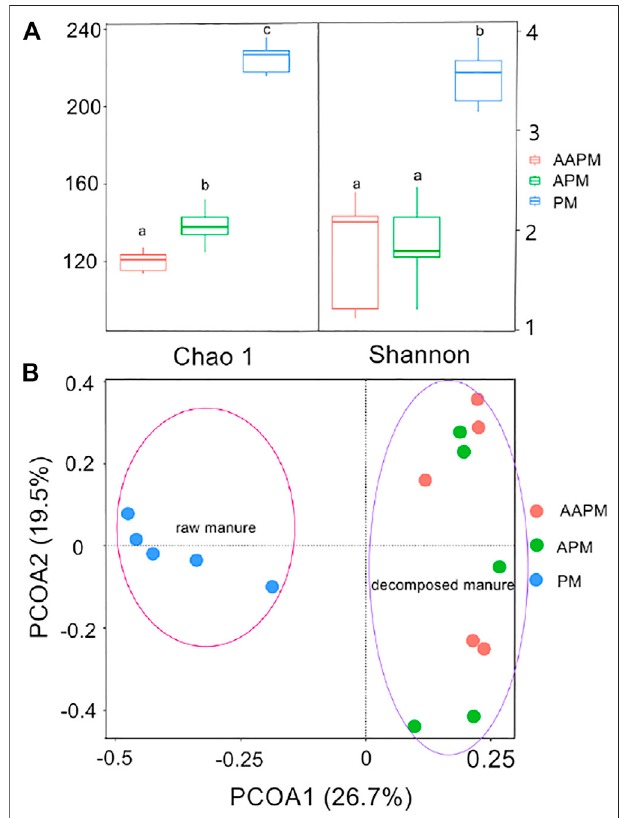
FIGURE1| α -diversityindexofARGsattachedtostrawberriescollected from fi elds with long-term use of raw poultry manure (PM), aerobic composting poultry manure (APM), and anaerobic composting poultry manure (AAPM) (A) . Principal coordinates analysis (B) ( n =